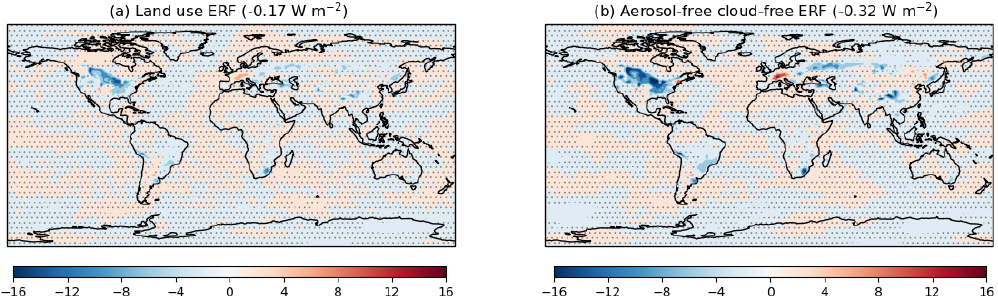
Figure 14. Global distribution of the present-day (PD; year 2014) ERF relative to the pre-industrial (PI; year 1850) period of (a) LU ERF and (b) the contribution from the cloud-free and aerosol-free component. Global mean values are included and areas are stippled where the ERF and/or its component are not statistically significant from zero at the 95% confidence interval. Units in Wm − 2